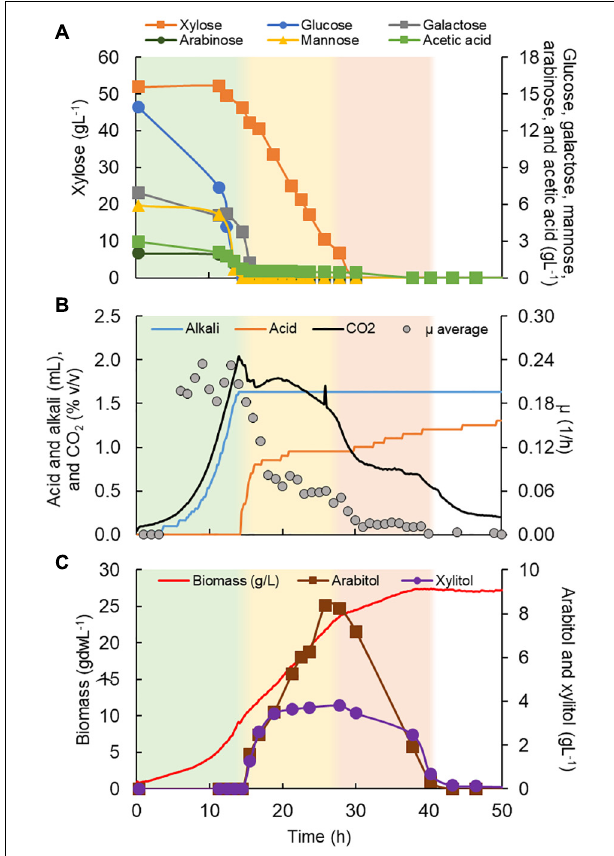
FIGURE 6 | Rhodotorula toruloides CCT 7815 characterization in a bioreactor in C5-Birch hydrolysate diluted to 81 gL − 1 of total sugars. (A) Xylose, glucose, galactose, mannose, arabinose, and acetic acid consumption profiles (gL − 1 ); (B) added alkali and acid profiles to maintain the constant pH, CO 2 production, and average specific growth rate ( µ , h − 1 ) profiles; and (C) xylitol and arabitol production and consumption profiles (gL − 1 ) and growth profile in biomass (gdwL − 1 ). The stationary phase is depicted in white; the first, second, and third growth phases are shown in green, yellow, and light orange, respectively. Supplementary Table 6 contains all data and errors expressed in standard